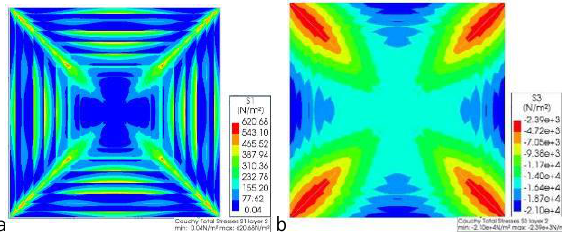
Figure 13. The main total stress results of linear analysis on the medium surface of the first model with pinned constraints: a. Tensile. b. Compression.